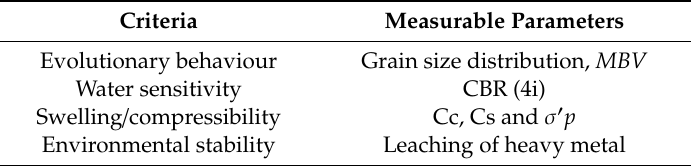
Table 2. Design criteria and quality monitoring